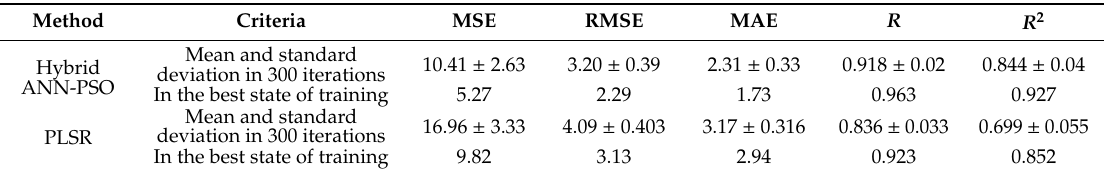
Table 14. Comparison of mean and standard deviation, di ff erent criteria evaluating the performance of the ANN-PSO algorithm and PLSR for estimating the taste index in 300 iterations using spectral data of key